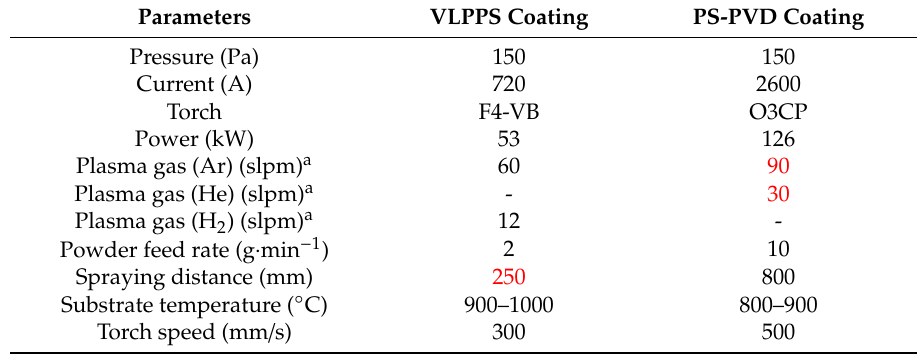
Table 2. Parameters of the very-low-pressure plasma spray (VLPPS) and plasma spray–physical vapor deposition